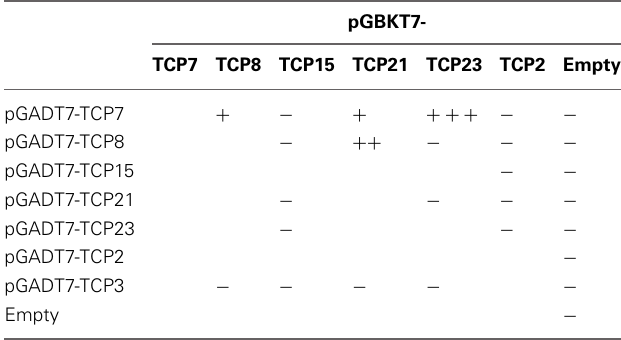
Table 1 | Protein–protein interactions between TCP factors using yeast-two